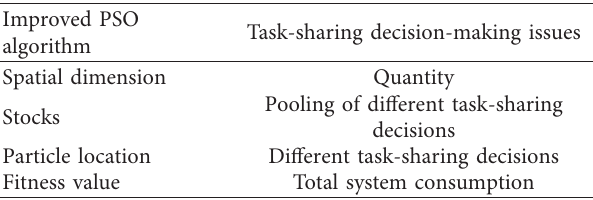
Table 2: The table describes the solution space of the improved PSO algorithm with respect to the task sharing decision